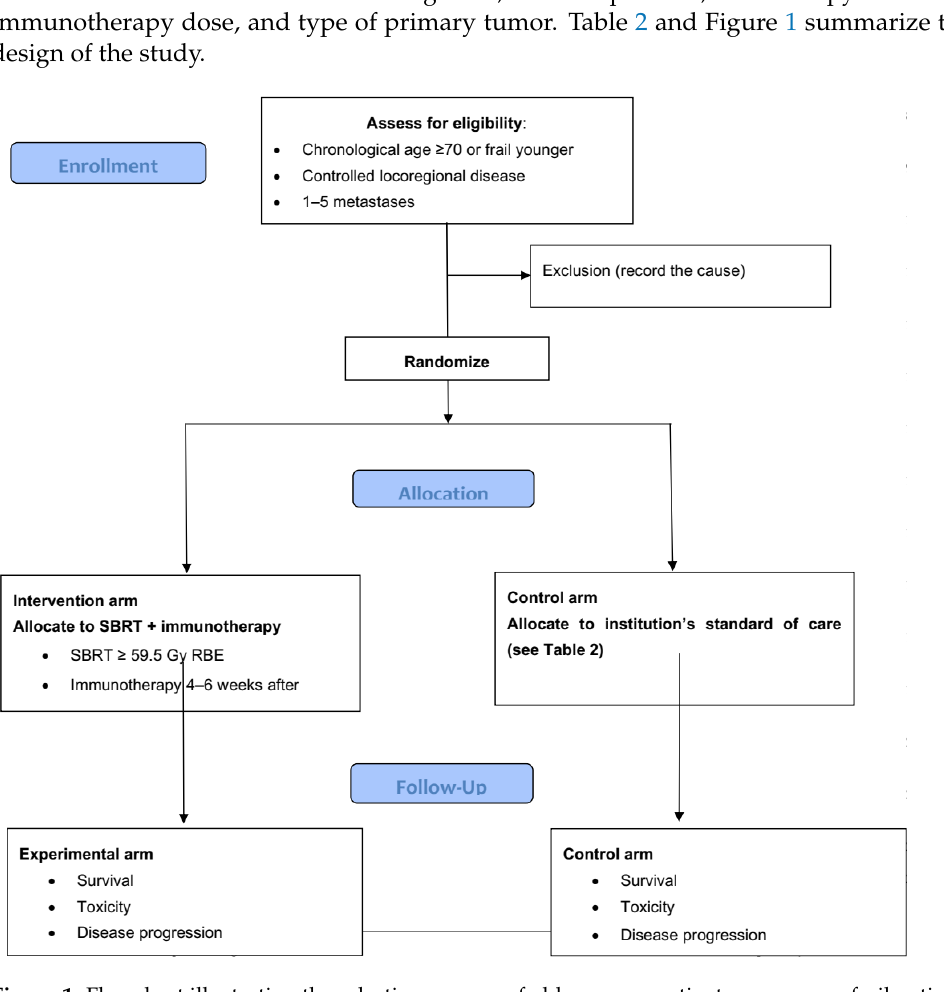
Figure 1. Flowchart illustrating the selection process of older cancer patients or younger frail patients with oligometastases. Table 2. Proposed randomized study to test the hypothesis that stereotactic body radiotherapy and immunotherapy may improve survival of older patients with oligometastases.